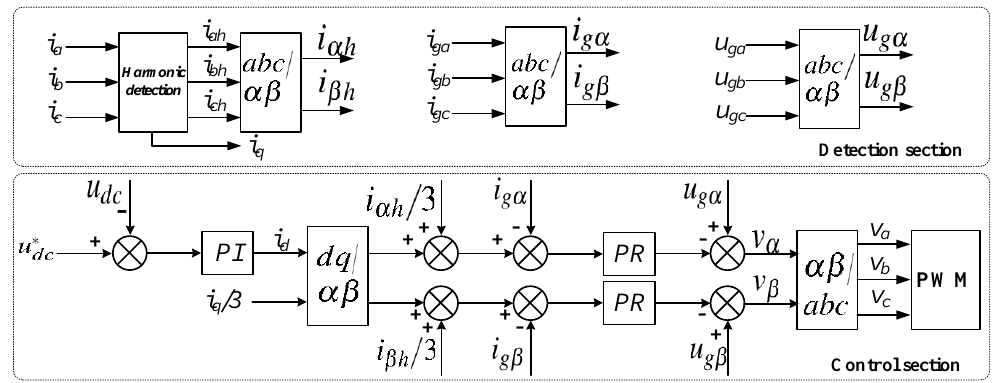
Figure 8. Control algorithm of the shunt converter. PR, proportional resonant controller.